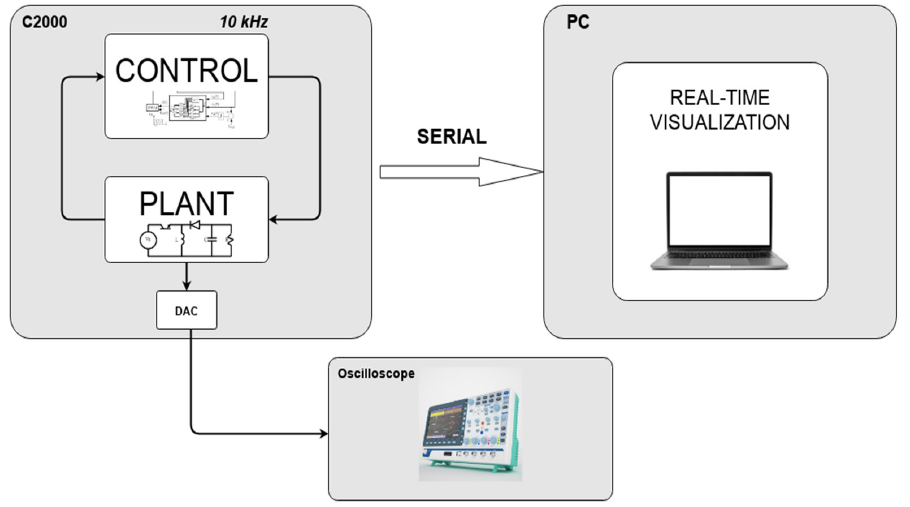
Figure 22. Real ‐ time digital hardware validation schematics of proposed scheme.